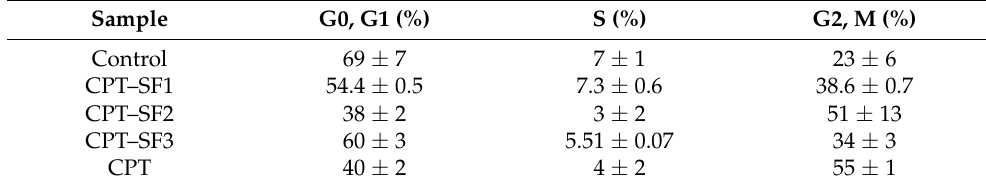
Table 3. MCF-7 cell cycle arrest parameters at control and 0.27 mg/mL of CPT-loaded SF nanoaggregates and parent CPT.